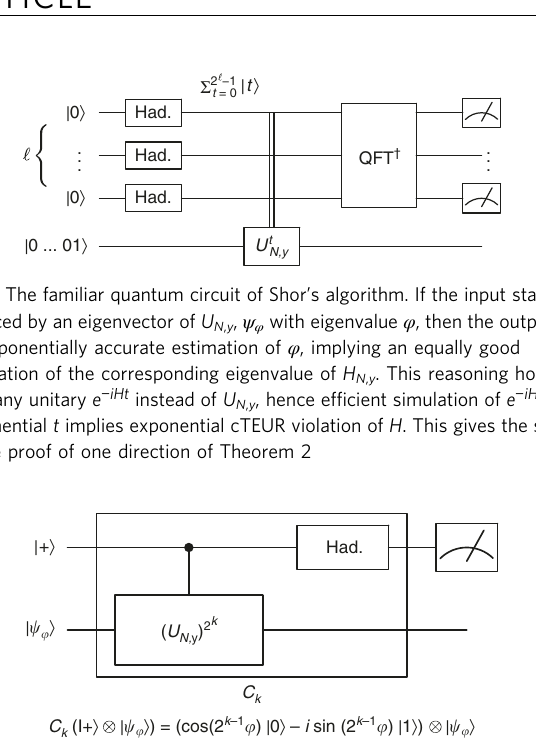
(cid:2) (cid:2) (cid:3) (cid:3) (cid:2) (cid:2) . The ¼ e i φ ψ φ 2